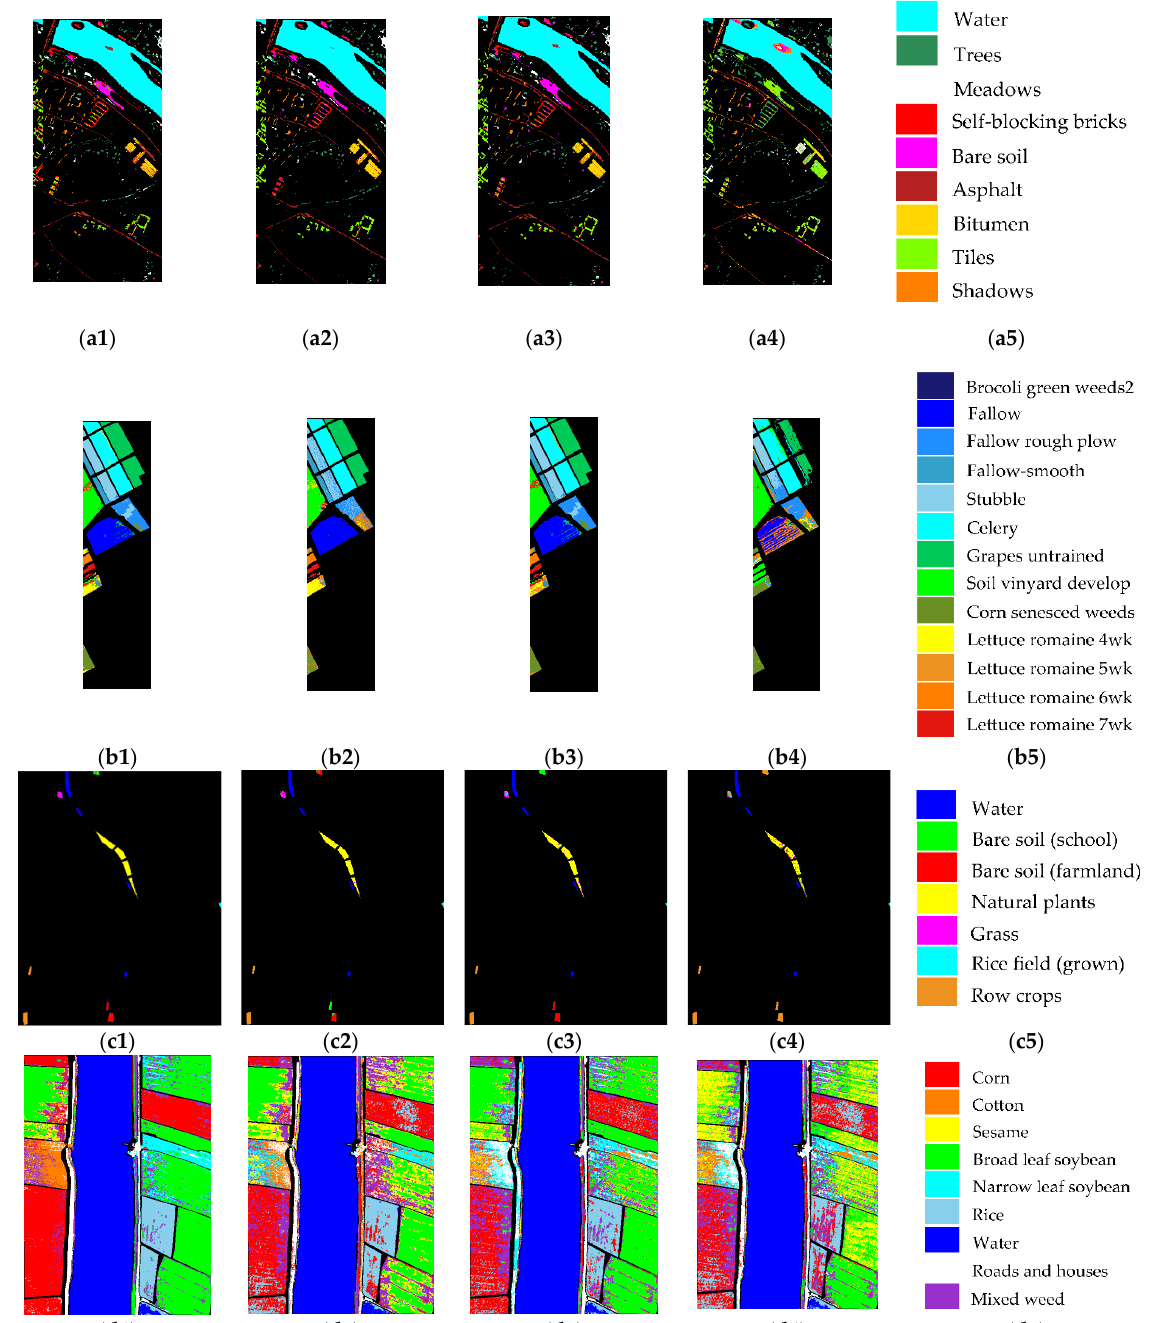
Figure 5. Comparison of the classification results of four images. ( a1 – d1 ) The proposed algorithm. ( a2 – d2 ) TRP-MIV algorithm. ( a3 – d3 ) PRP-MGSR algorithm. ( a4 – d4 ) CAFCM algorithm. ( a5 – d5 ) The legends for all classes.